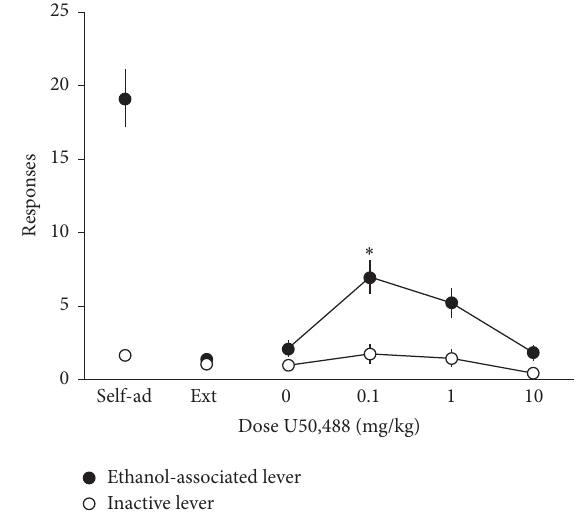
Figure 3: U50,488 reinstates ethanol-seeking behavior. Rats ( 𝑛 =